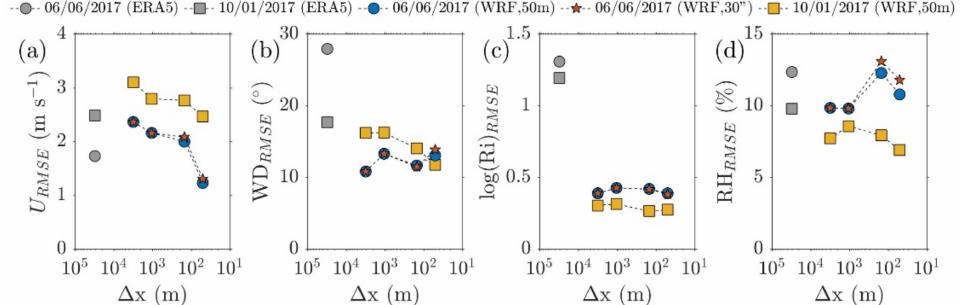
Figure 10. Root mean square error (RMSE) values comparing rawinsonde data against ERA5 and WRF output data from 0–10 km asl at 0900 JST against horizontal grid spacing ( ∆ x ) for: ( a ) horizontal velocity ( U ), ( b ) wind direction (WD), ( c ) the logarithm of the Richardson number (log(Ri)), and ( d ) relative humidity (RH). Results from different simulations are shown using different markers are shown in the legend. WRF output data are averaged over a 31 km area for each domain. Note that a logarithmic scale is used in the x–axis.